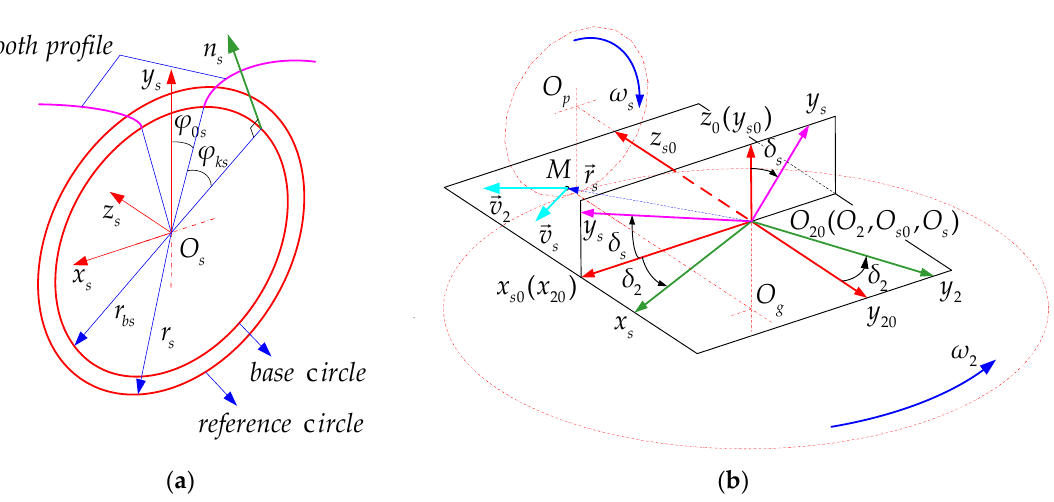
Figure 2. ( a ) Tooth profile of the shaper cutter; ( b ) machining coordinates of the face gear pair.